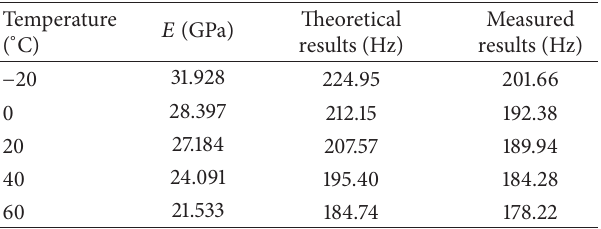
Table 8: Theoretical and measured results of the first order fre- quency for concrete